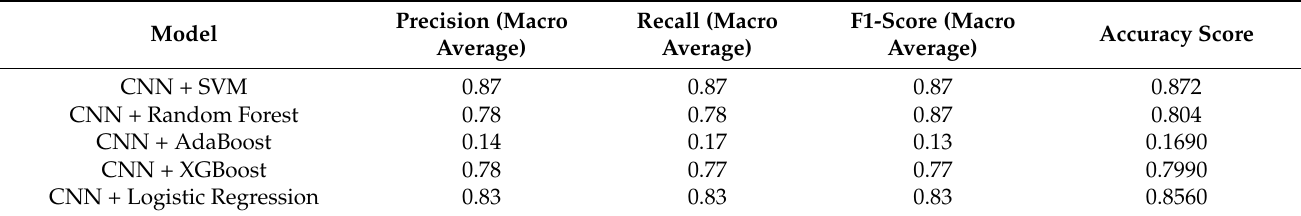
Table 10. Hybrid machine-learning models trained on the Arabic character dataset.